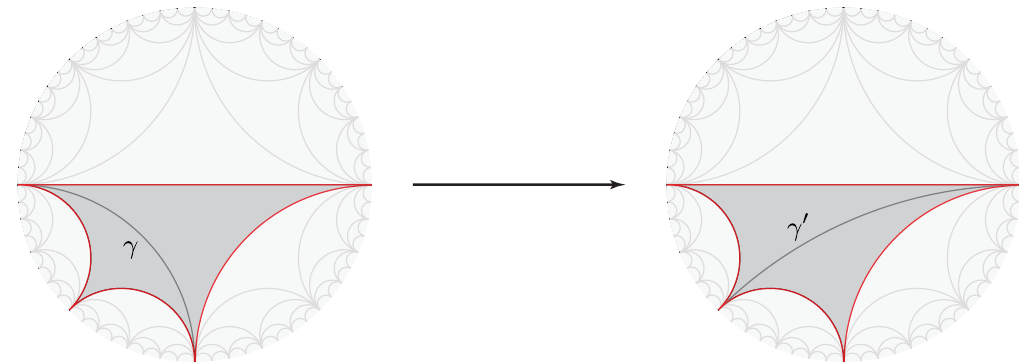
Figure 20 . In a Pachner (cid:13)ip, or elementary move, the diagonal (cid:13) in the shaded quadrilateral is replaced by the other diagonal (cid:13) 0 . The result is a new tessellation of the Poincar(cid:19)e